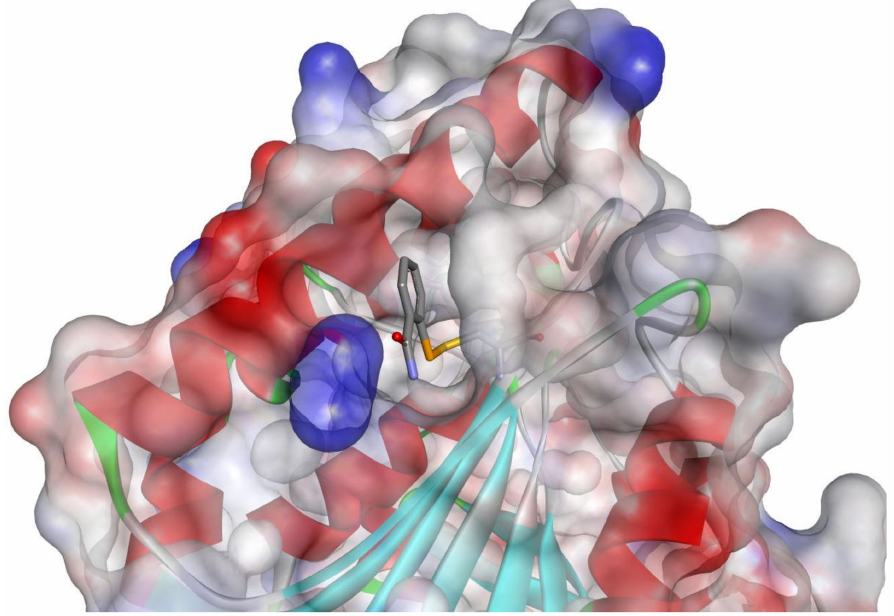
Figure 2. Binding mode of ebselen with antigen 85C (Protein Data Bank (PDB): 4QDU). The inhibitor reacted with C209 is shown as sticks, while the enzyme is shown as a ribbon. The surface of the protein is colored according to the